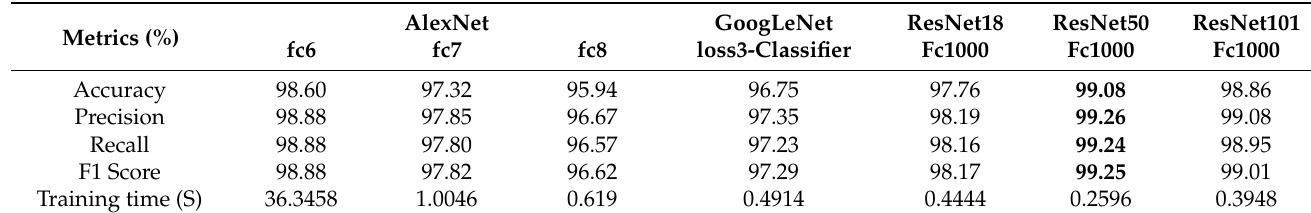
Table 4. Performance metrices and training time of SVM classifier with single deep feature (bold font shows the best performance). Metrics